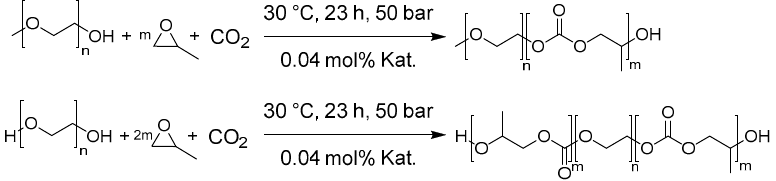
Table 1. Overview of all characterization data for all AB and ABA